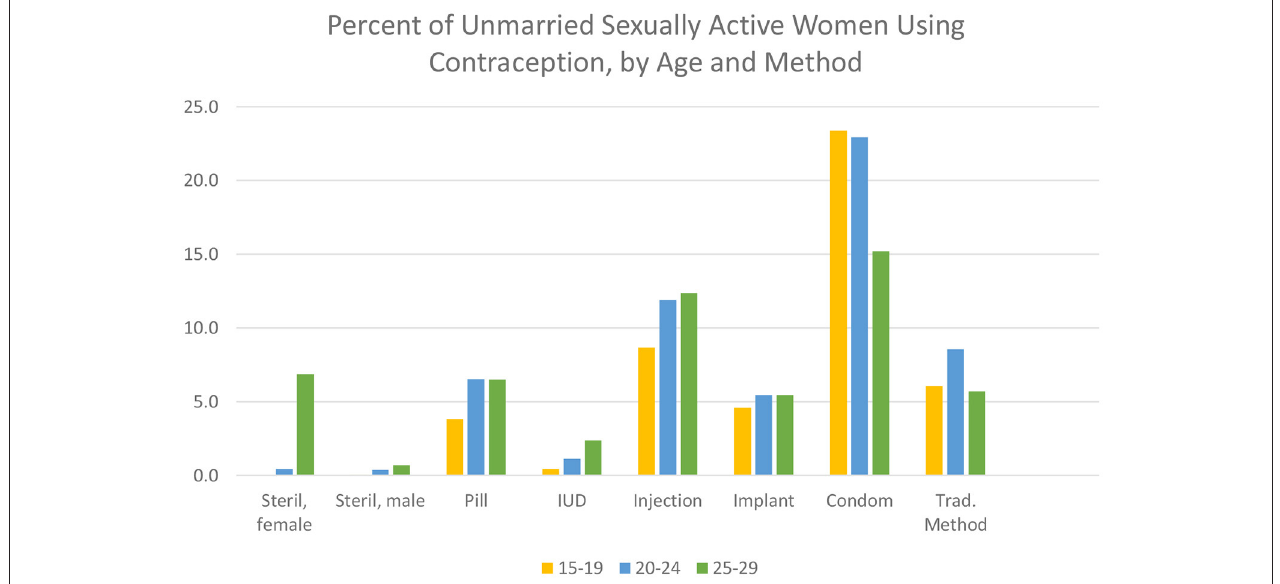
FIGURE 9 | Percent of unmarried sexually active women using contraception, by age and